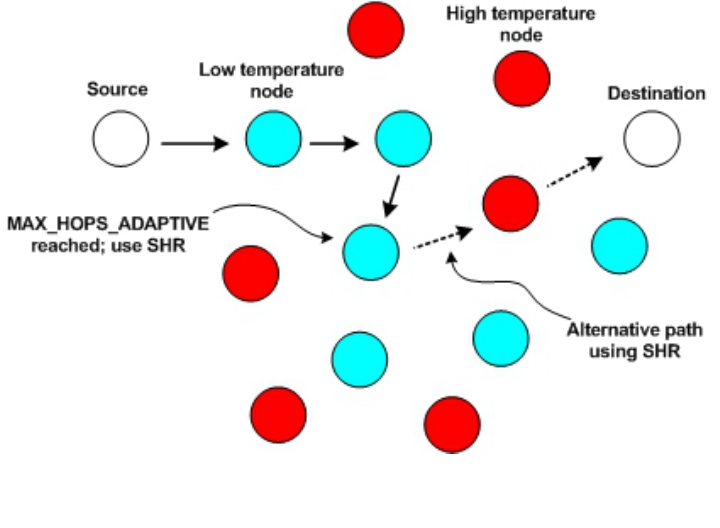
Figure 5. An example of Adaptive Least Temperature Routing